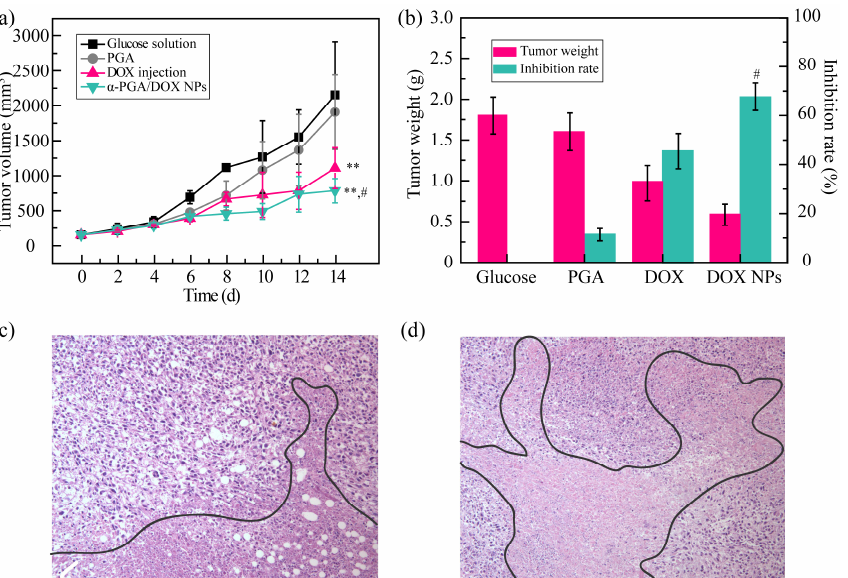
Figure 6. Antitumor results on 4T1 tumor-bearing mice in vivo: tumor volume change curves ( a ), tumor inhibition rate ( b ), tumor tissue images of the DOX group ( c ) and the α-PGA/DOX NP group ( d ) ( n = 10). ** p < 0.01, vs. glucose solution; # p < 0.05, vs. DOX injection.